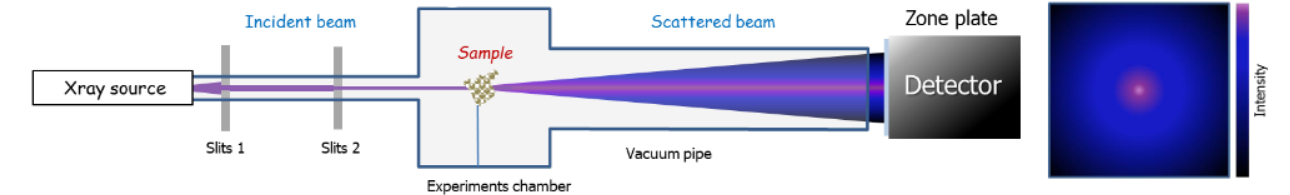
Figure 22. Schematic representation of SAXS instrumentation developed by XENOCS.